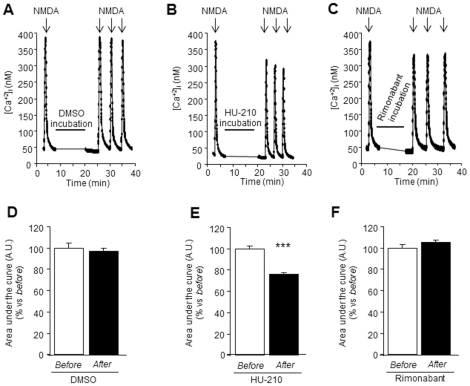
The stimulation of the endocannabinoid system reduces NMDA-stimulated calcium influx in ethanol-withdrawn neurons.(A, B, C) Representative recordings of single-cell calcium videomicroscopy for each experiment. A 30 sec exposure to NMDA (50 µM) produced a rapid calcium influx, which recovered over the following 2 min (before). (E) After the incubation (10 min) with the non-specific CB1 agonist HU-210 (1 µM), Ca2+ influx (induced by NMDA application) is significantly decreased in comparison to the stimulation before. Incubation (10 min) with DMSO (D) or rimonabant (1 µM) (F) does not modify NMDA-stimulated calcium influx. Values are expressed as % vs. before NMDA-stimulation ± SEM (N = 3–4; n (cell number) >60 cells). Data were analyzed by the t Student's test. (***P<0.001).